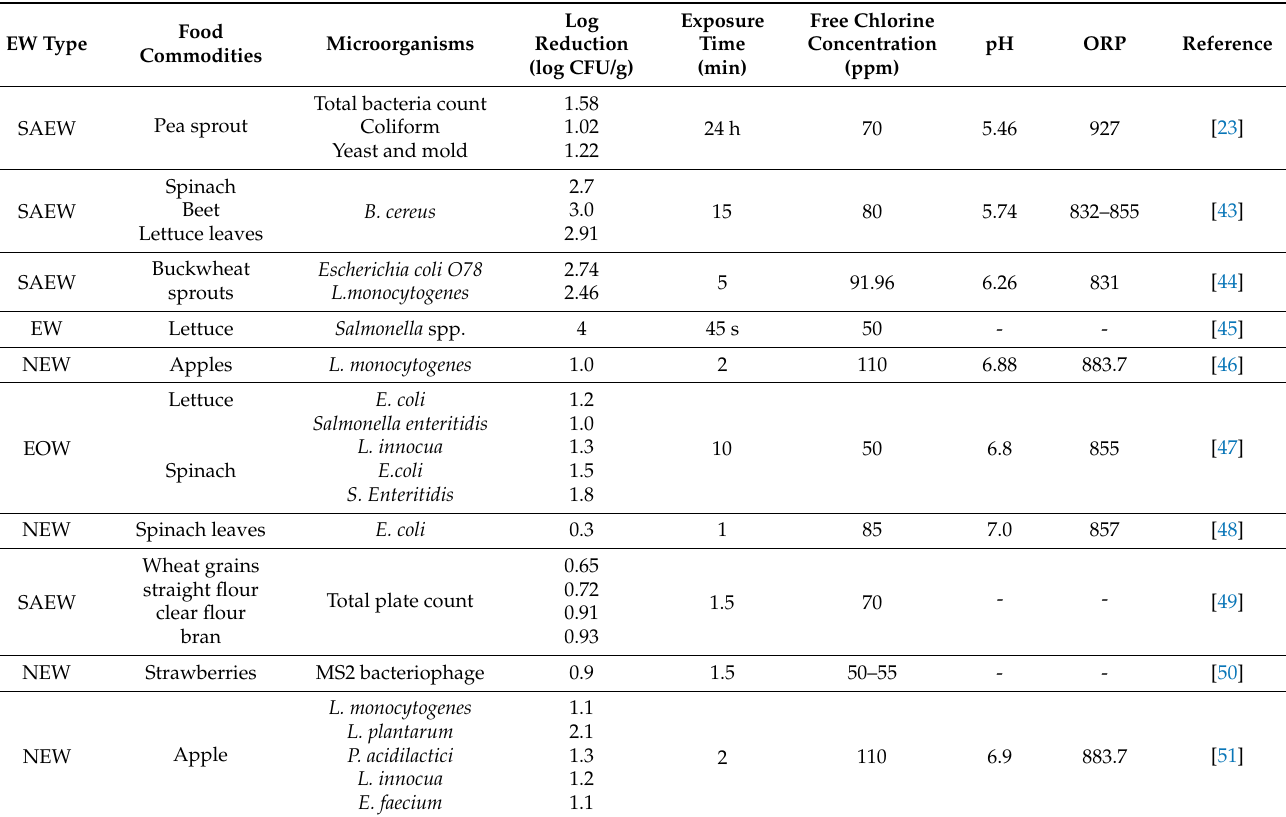
Table 1. Application of EW in disinfecting various vegetables and